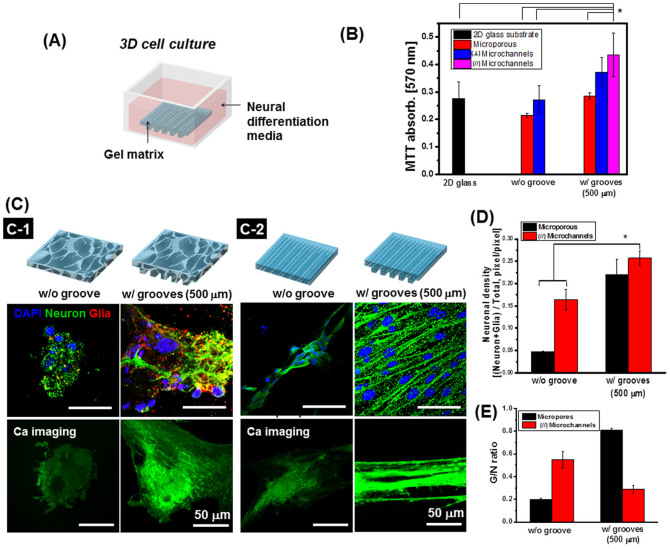
Effects of hydrogel permeability on metabolic activity and neural differentiation of BMSCs.(A) Schematic representation of the 3D BMSC culture using RGD-alginate matrix with controlled permeability. (B) The combined effect of microgrooves and micropores/microchannels on cellular metabolic activity. Data are mean ± SE, n = 5/condition (*p < 0.05). (C) Confocal images of microtubule-associated protein 2 (MAP2, green color) and glial fibrillary acidic protein (GFAP, red color) of neural networks formed within the RGD-alginate hydrogel (2nd row) and Ca2+ signal (green color) of differentiated neurons (3rd row). Cells displayed in confocal images represent those located at depth of 60 μm fro the top surface of the gel. At least 600 cells were analyzed from 5 gels per condition. (C-1) Differentiated neuronal cells in the microporous RGD-alginate hydrogels without grooves (i.e., w/o groove) and those with grooves of 500 μm-spacing. (C-2) Differentiated neuronal cells in the (//) microchanneled RGD-alginate hydrogel without microgrooves (i.e., w/o groove) and those with microgrooves of 500 μm-spacing (i.e., w groove). (D) Quantitative analysis of the neuronal density within the RGD-alginate hydrogel: The neuronal density was defined as the areal fraction of glial cells and neuron in the confocal images. (E) Analysis of the ratio between glia and neuron (G/N ratio) in the hydrogels with controlled microgroove spacing. Data are mean ± SE, n = 5/condition (*p < 0.05).